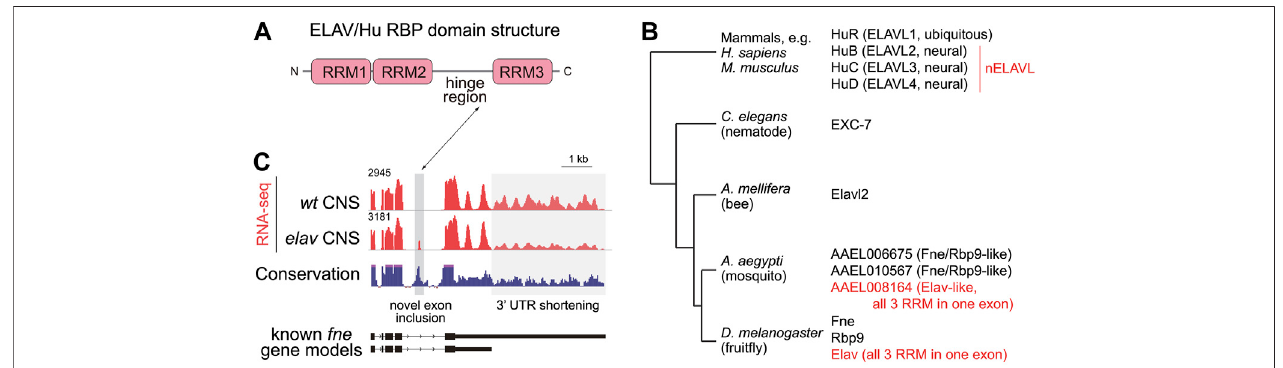
FIGURE 2 | Phylogeny and alternative processing of ELAV/Hu RNA binding proteins (RBPs). (A) All members of the ELAV/Hu family share a common structure including 3 RNA recognition motifs (RRMs) and a hinge between RRM2 and RRM3. (B) Distinct numbers of ELAV/Hu RBP genes in different metazoan species suggest that multiple ampli fi cations of the family occurred during evolution. Note that while many homologs are referred to as “ Elav-like, ” based on the founding member from fl ies, Drosophila Elav is actually an evolutionarily derived retrogene. Phylogenetic tree is modi fi ed from (Samson, 2008). (C) Cross-regulation of Drosophila fne mRNA isoforms by Elav. RNA-seq data (red tracks) from wildtype CNS shows substantial expression of an extended 3 ’ UTR isoform of fne , while elav mutant CNS expresses a shorter fne 3 ’ UTR isoform that also includes a novel microexon that can direct Fne towards the